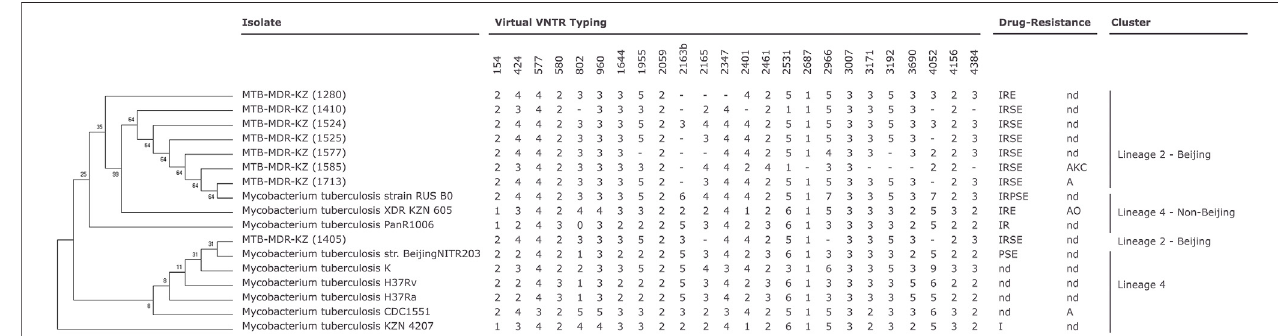
FIGURE1| Phylogeneticrelationshipsof Mycobacterium ( M ) .tuberculosis isolatesbasedonhigh-qualitysingle-nucleotidepolymorphisms(SNPs)identi fi edbyCSI Phylogenytool(Kaasetal.,2014)fromwhole-genomesequences.Thetreewasconstructedbytheneighbor-joiningmethod.Mycobacterial interspersedrepetitiveunit- variable number of tandem repeats (MIRU-VNTR) genotyping analysis of the 17 M. tuberculosis isolates ( Supplementary Data S3 ). MIRU-VNTR dendrogram of the eight multidrug-resistant (MDR) M. tuberculosis clinical isolates. First-line drug susceptibility testing: I, isoniazid; R, rifampicin; S, streptomycin; E, ethambutol; P, pyrazynamid.Second-linedrugsusceptibilitytesting:K,kanamycin;A,amikacin;C,capreomycin;O,o fl oxacin;nd,notdetermined;-,notdeterminednumberoftandem repeats (virtual VNTR